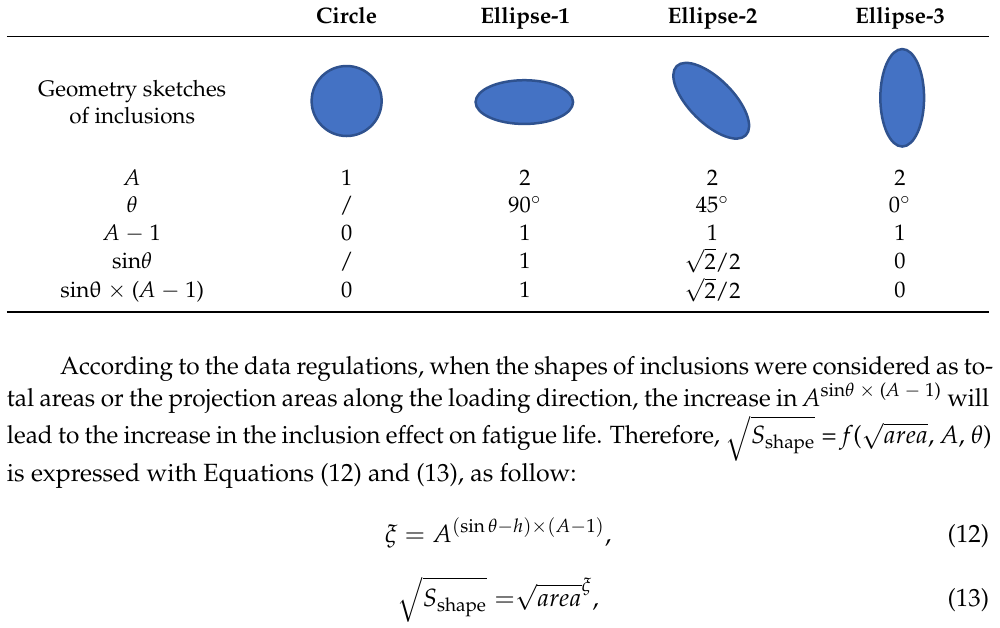
Table 5. Values of expressions in the function to describe inclusion shape.